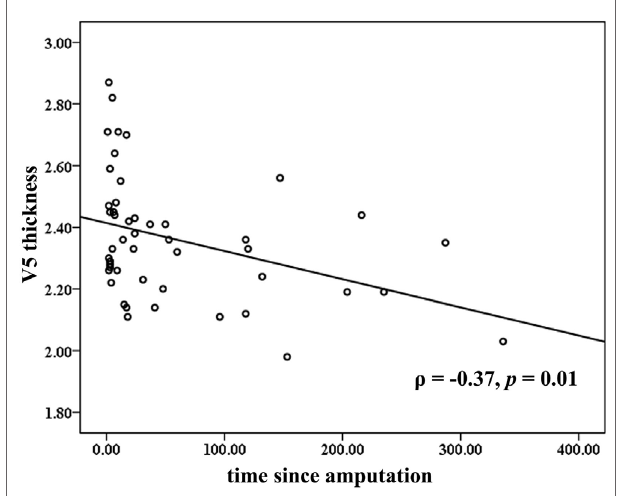
FigUre 2 | correlations between mean cortical thickness of the bilateral V5 and time since amputation . The partial correlation coefficient ( ρ ) was corrected for age and